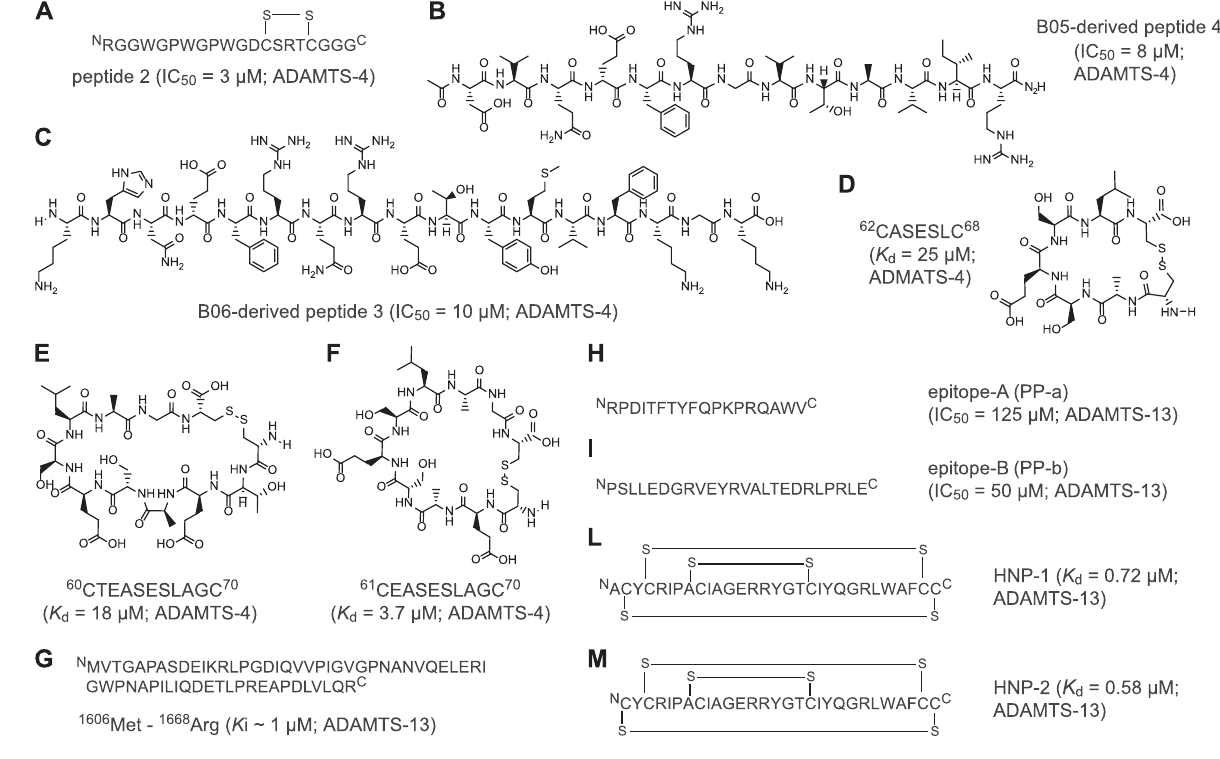
FIGURE 2 | Peptide inhibitors of ADAMTS proteins. (A) Aminoacidic sequence of linear peptide 2 derived from the C-terminus TSP-1 motif of aggrecanase-1; (B) Chemical structure of B05-derived linear peptide 4 (KHN(e)FRQRETYMVFKGK); (C) Chemical structure of B06-derived linear peptide 3 (DVQ(e)FRGVTAVIR); (D) Chemical structure of cyclic peptide 62 CASESLC 68 ; (E) Chemical structure of cyclic peptide 60 CTEASESLAGC 70 ; (F) Chemical structure of cyclic peptide 61 CEASESLAGC 70 ; (G) Aminoacidic sequence of linear peptide VWF-73 peptide (Met 1606 -Arg 166 ) derived from C-terminal region of the multimeric von Willebrand factor (VWF); (H) Aminoacidic sequence of linear peptide epitope-A (PP-a); (I) Aminoacidic sequence of linear peptide epitope-B (PP-b); (L) Aminoacidic sequence of polycyclic human neutrophil peptide 1 (HNP-1); (M) Aminoacidic sequence of polycyclic human neutrophil peptide (HNP-2). Indicated half maximal inhibitory concentration(IC 50 ),inhibitionconstant( K i )anddissociationconstant( K d )valueswerereportedaspublished.ThetargetedADAMTSproteinisreportedneartheIC 50 , K i, or K d value.